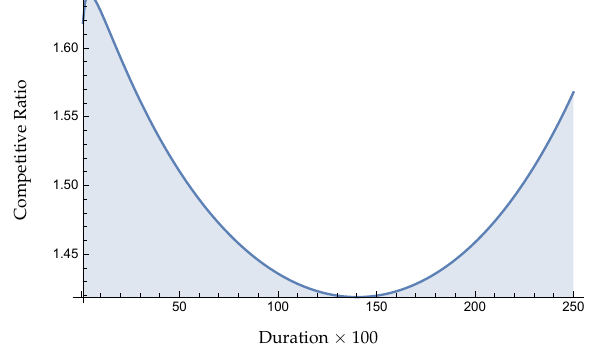
Figure 17. Competitive ratio t = 0.312, z = 0.1.